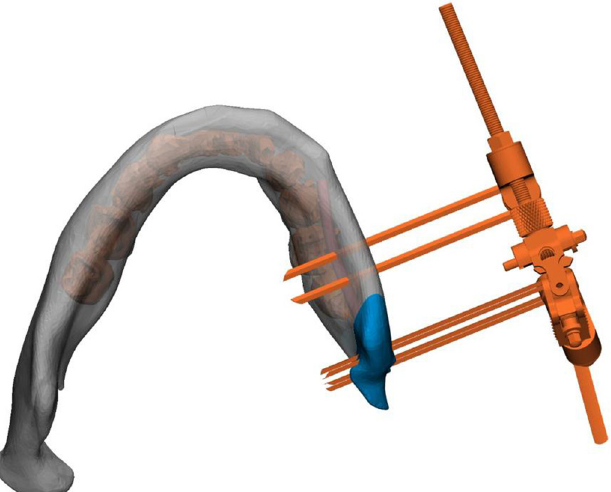
Fig. 3. Virtual planning in bottom view.